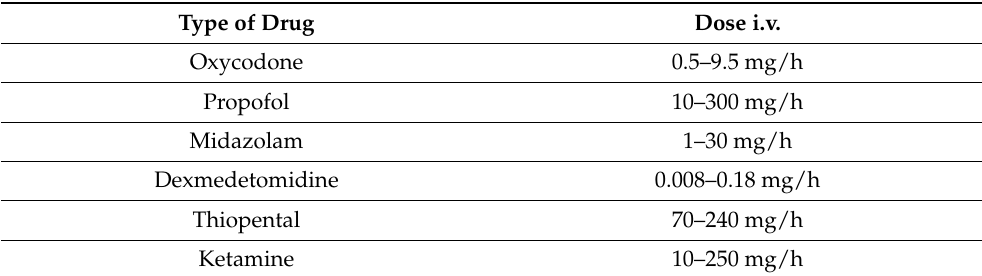
Table 1. Average doses of analgesics and sedatives used in the study group.